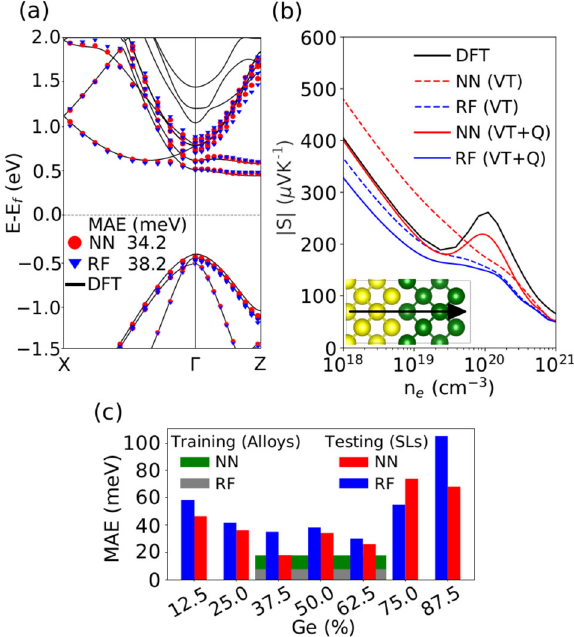
Fig. 4 Test of local structure-energy bands transferability hypothesis. a Energy bands of relaxed Si 4 Ge 4 SL predicted with ML algorithms and compared with DFT results. ML model is trained on 350 disordered units, and tested on 7 relaxed SL structures. b Comparison between thermopowers obtained with DFT (black) and ML algorithms, NN (red) and RF (blue). ML models are trained with all Voronoi tessellations (VT) derived features except the order parameters (Q) (dashed) and including order parameters (VT + Q) (solid), respectively. Improved match upon including Q features can be noted. c Train and test MAE of ML-predicted